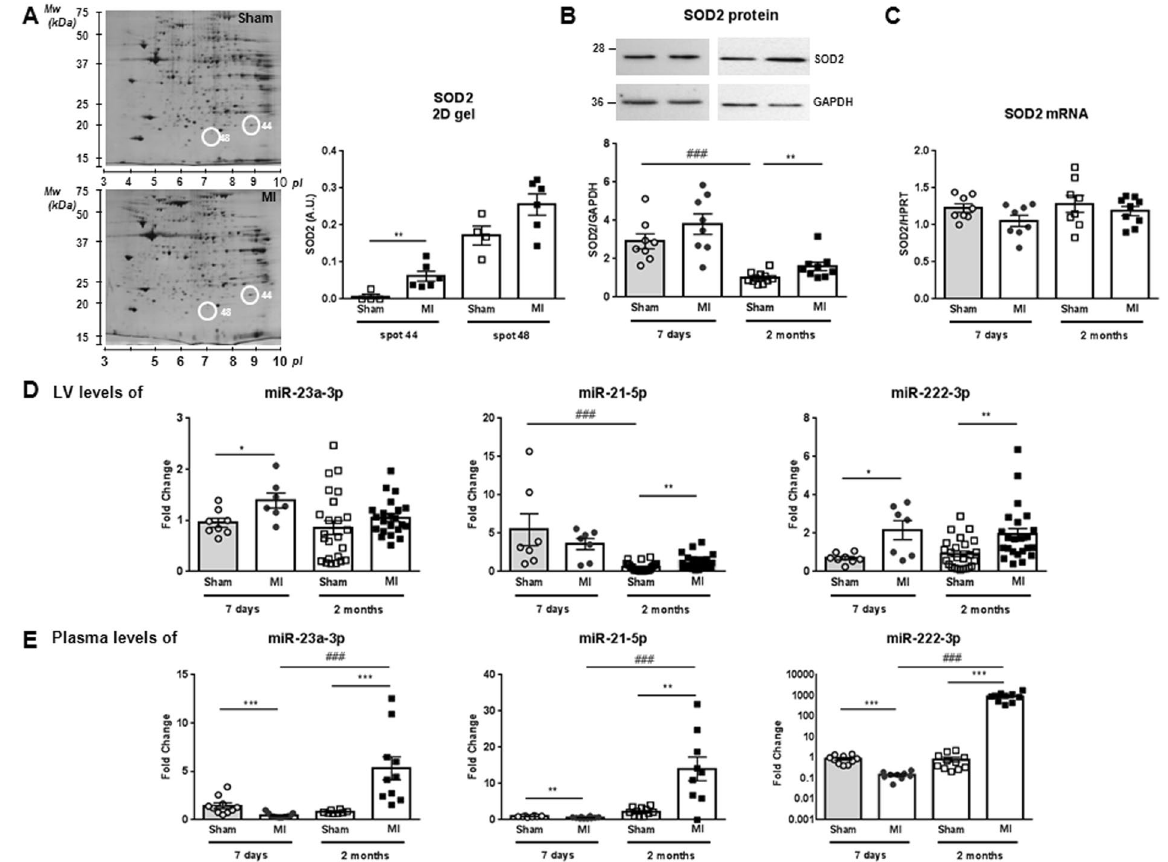
Figure 1. SOD2 and miRNAs expression in LV and plasma of MI-rats. ( A ) Representative 2D-gel of rat LV proteins from sham and 2-months MI-rats (left panel). The positions of molecular weight (Mw) are indicated on the left and the pI on the bottom of the gels. Spots identified by mass spectrometry as SOD2 are encircled. Spots number correspond to proteomic analysis previously published 3 . Quantification of the 2 spots corresponding to SOD2 was obtained from 4 sham- and 6 MI-rats (right panel). ( B ) Representative western blot of SOD2 protein in LV extracted from rat 7 days (circle, n = 8) and 2 months (square, n = 8) after MI (n = 16) or sham (n = 16) surgery. Data were normalized to GAPDH for western blot. ( C ) RT-qPCR of SOD2 mRNA in LV extracted from rat 7 days (circle, n = 8) and 2 months (square, n = 8) after MI (n = 16) or sham surgery (n = 16). Data were normalized to HPRT for RT-qPCR. ( D ) RT-qPCR of miR-21-5p, miR-23a-3p and miR-222-3p in LV extracted from rat 7 days (circle, n = 8) and 2 months (square, n = 8) after MI (n = 16) or sham (n = 16) surgery. Data were normalized to miR-423-3p for LV and graph shows mean ± SEM values expressed as fold change (2 − ΔΔ Ct). ( E ) RT-qPCR of miR-21-5p, miR-23a-3p and miR-222-3p in plasma extracted from rat 7 days (circle, n = 9) and 2 months (square, n = 9) after MI (n = 18) or sham (n = 18) surgery. Data were normalized to Cel- 39 for plasma and graph shows mean ± SEM values expressed as fold change (2 −ΔΔ C t ). * p < 0.05; ** p < 0.01; *** p < 0.001, for 2 groups’ comparison (nonparametric Mann–Whitney test) and ###p < 0.001, for multiple groups’ comparison (Kruskall-Wallis with Dunn’s multiple comparison